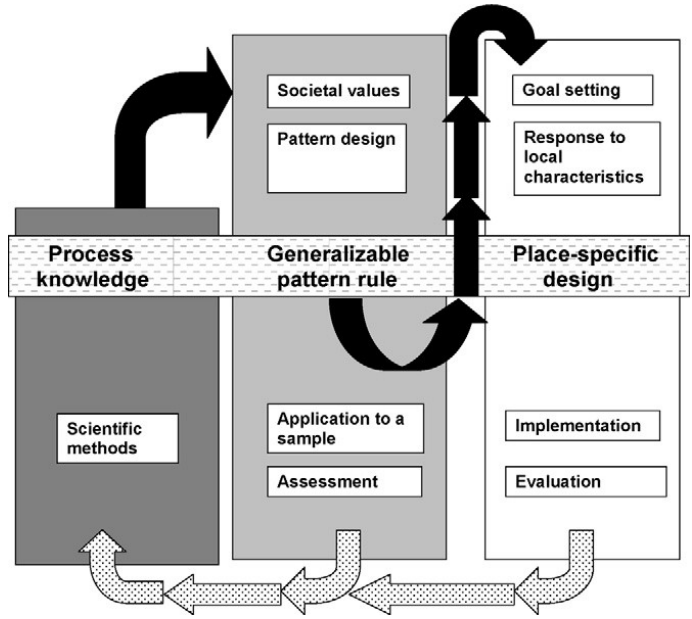
Fig. 1 Landscape design implementation